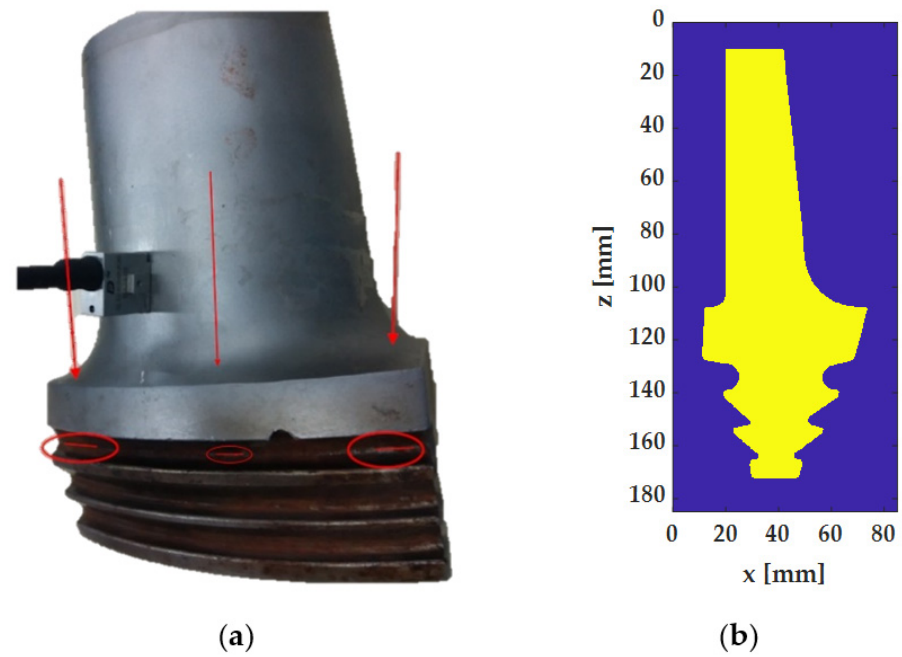
Figure 2. ( a ) Photo of a turbine blade and ( b ) typical cross section.